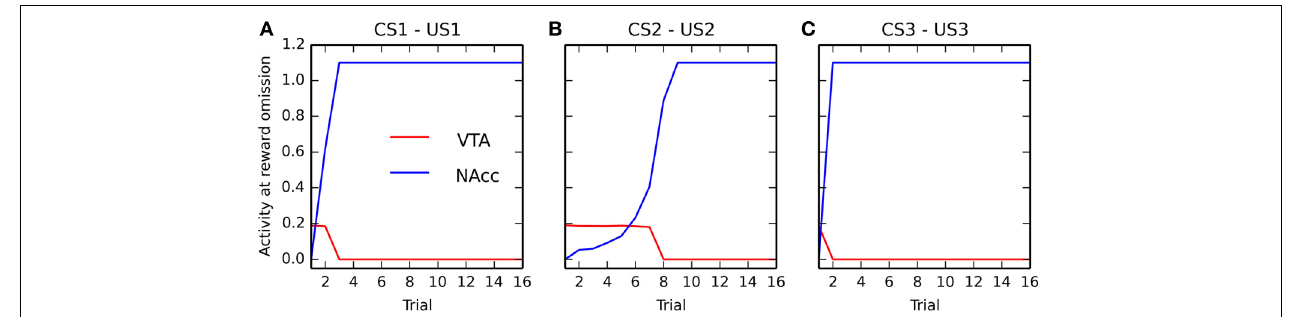
FIGURE 9 | ApparitionofVTAdipsduringconditioning. ForthethreeCS-US associations (panels (A–C) , respectively), the panel represents what would happen in VTA (red) and NAcc (blue) if the reward were omitted directly after eachconditioningtrial.Learningisshutoffduringtheseomissiontrials.Thered line shows the minimal activity in VTA during these omission trials. After the